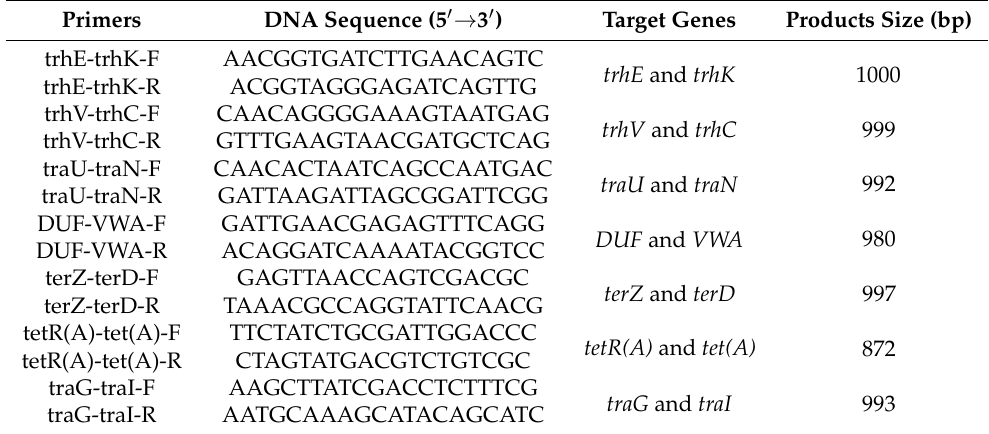
Table 5. Primer sequences used for the detection of pmcr_M15071H-like plasmids. Primers DNA Sequence (5 (cid:48) → 3 (cid:48) ) Target